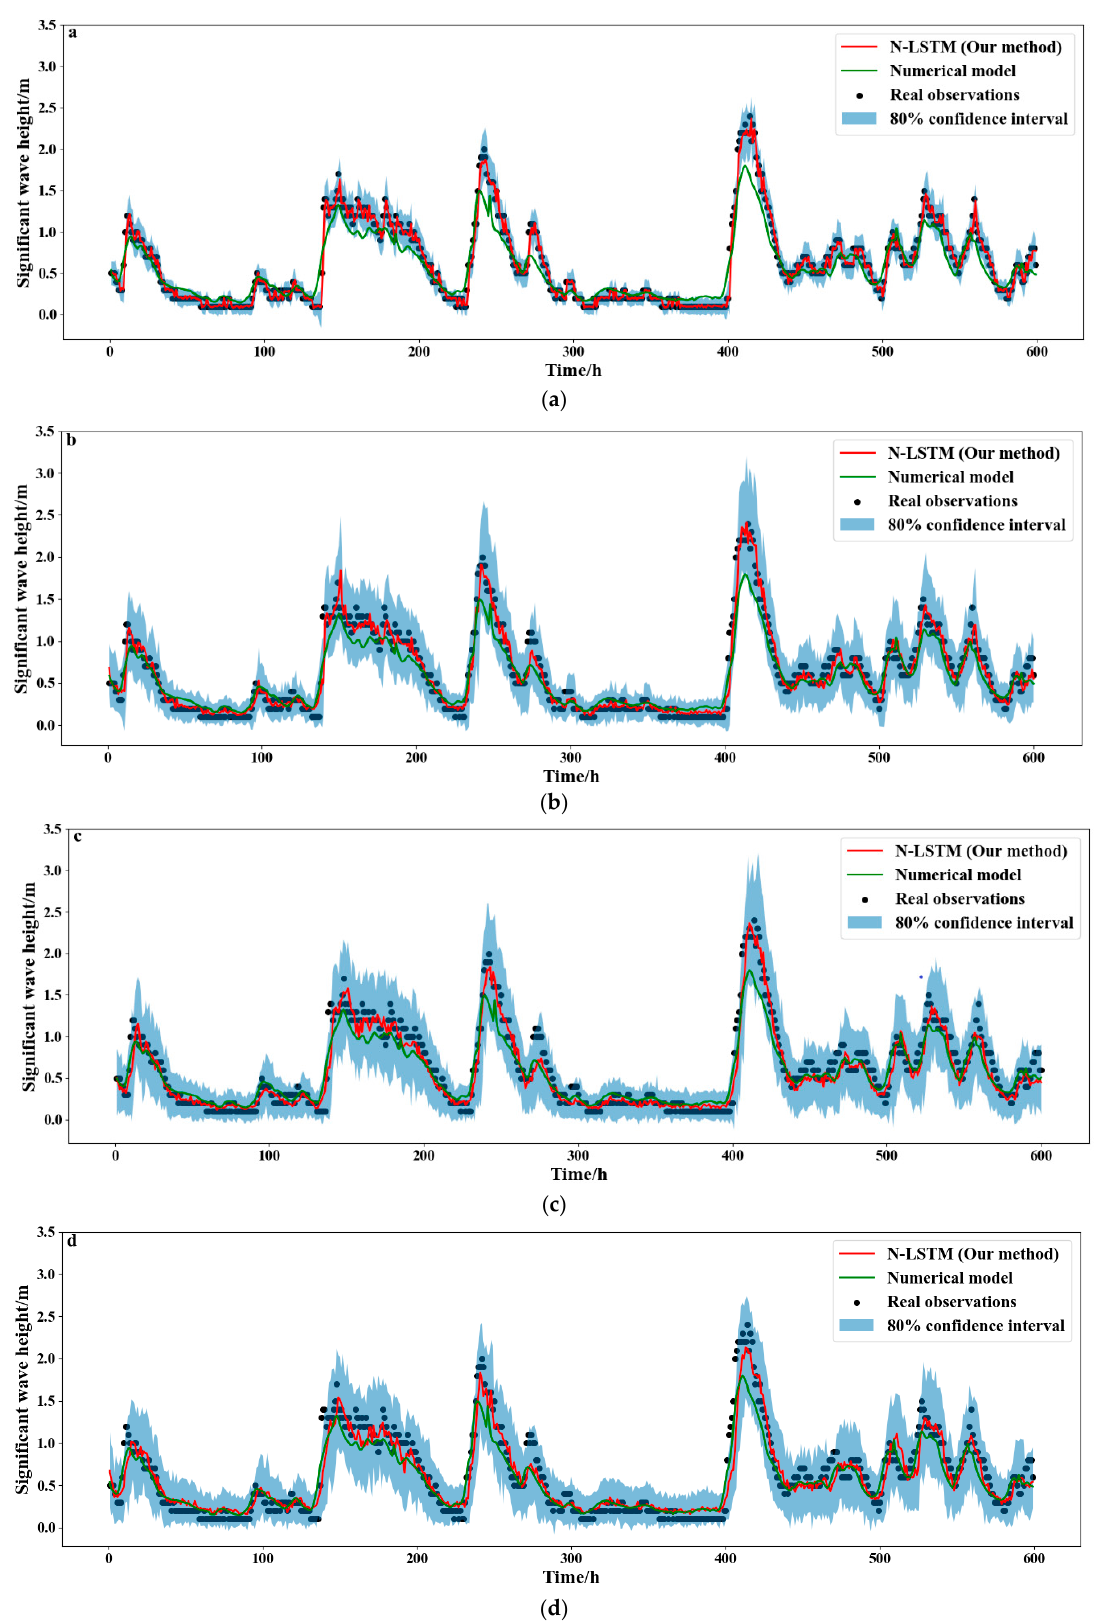
Figure 8. Wave height probabilistic predictions with 80% confidence interval for 1–3 and 48 h (shaded area): ( a ) One-hour forecasting; ( b ) two-hour forecasting; ( c ) three-h forecasting; ( d ) 48-h forecasting.